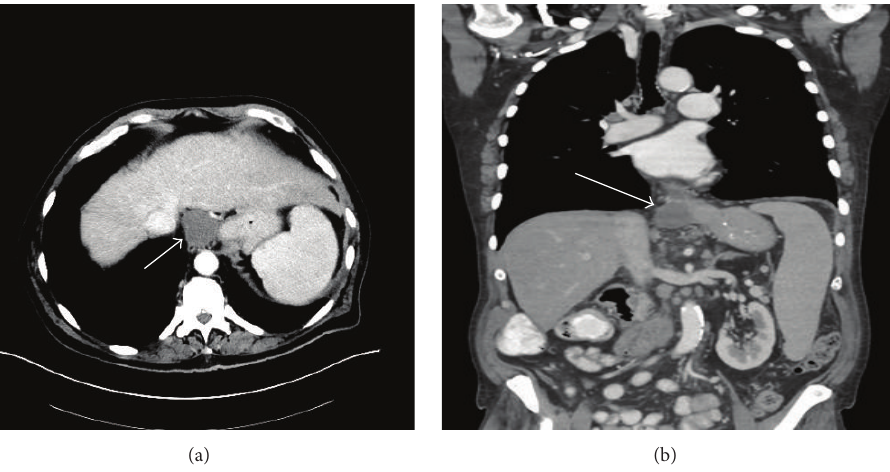
Figure 1: (a) Intravenous contrast enhanced axial CT scan of the abdomen demonstrates a well-circumscribed, low-attenuating, nonenhancing mass (arrow) adjacent to the gastroesophageal junction representing an enteric duplication cyst. (b) Coronal reformat of the intravenous contrast enhanced CT scan of the abdomen also demonstrates a well-circumscribed, low-attenuating, nonenhancing mass (arrow) adjacent to the gastroesophageal